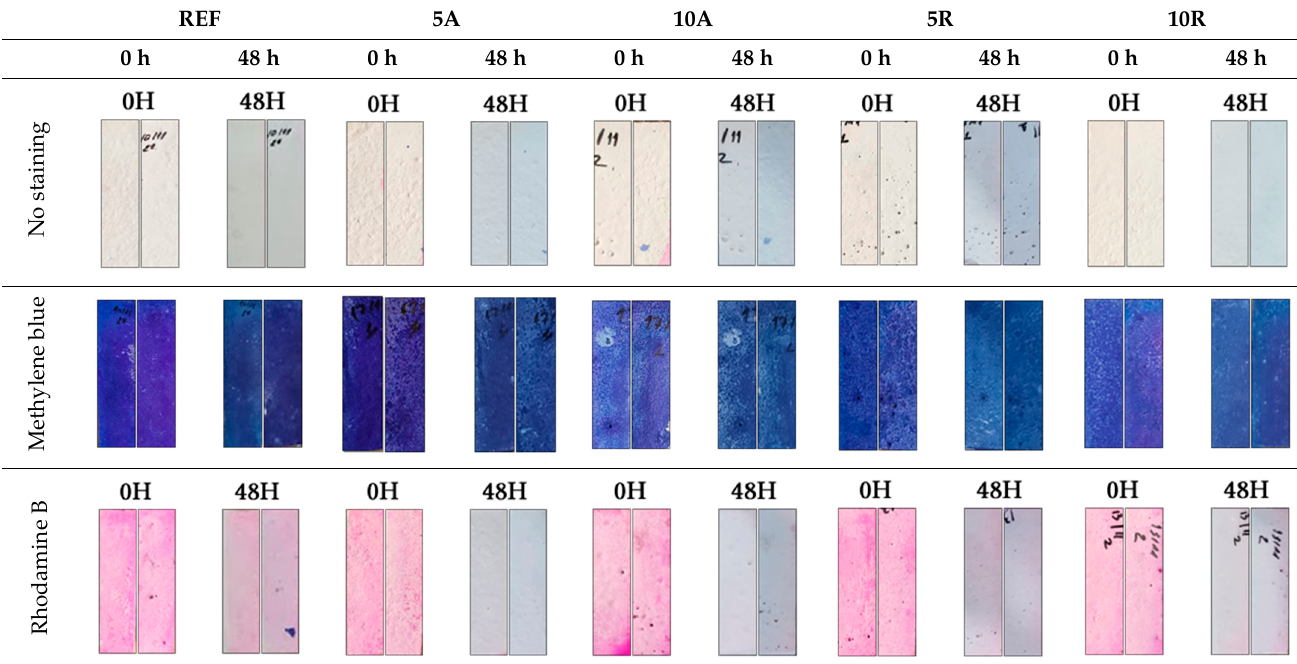
Table 9. Visual appearance of cement tiles, before and after exposure to UVA radiation, per different stains and TiO 2 contents.